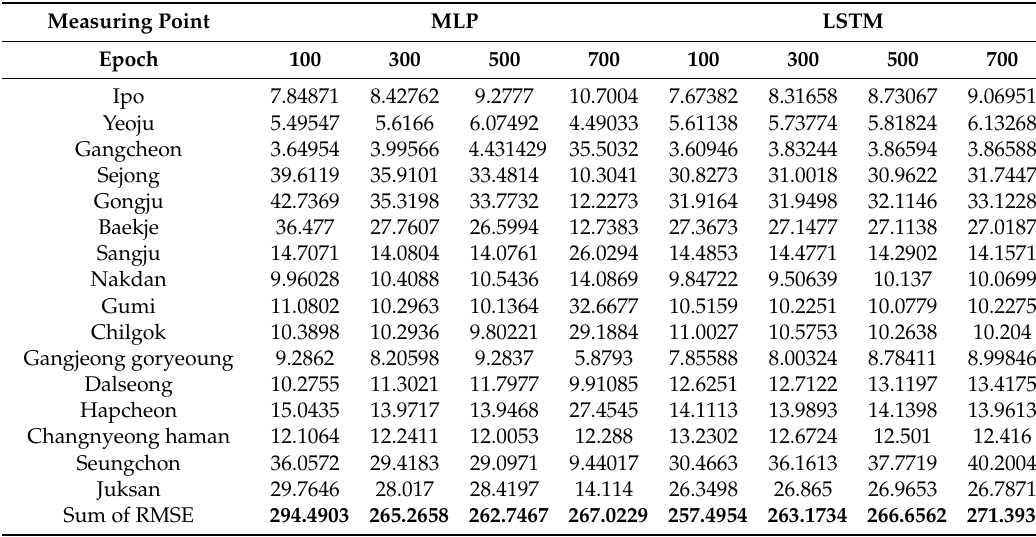
Table 3. Results of RMSE comparison by epoch.